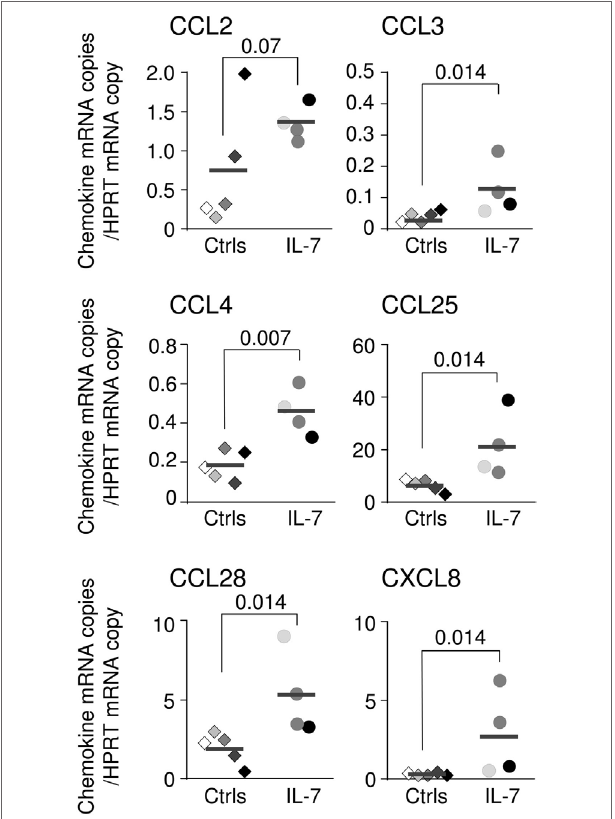
FigUre 4 | chemokine expression in the intestinal tract of interleukin (il)-7-treated rhesus macaques . CCL2, CCL3, CCL4, CCL25, CCL28, and CXCL8 mRNA expression in ileal tissues (three to five samples per macaque) sampled from five control rhesus macaques (macaques #1–#5; diamonds) and four healthy animals sacrificed 12 h (light gray circles), 1 day (dark gray circles), or 7 days (black circles) after systemic IL-7 treatment (80 μ g/kg of body weight). Medians are shown as horizontal bars. Statistically significant differences between IL-7-treated and untreated monkeys were calculated using Mann–Whitney one-tail U